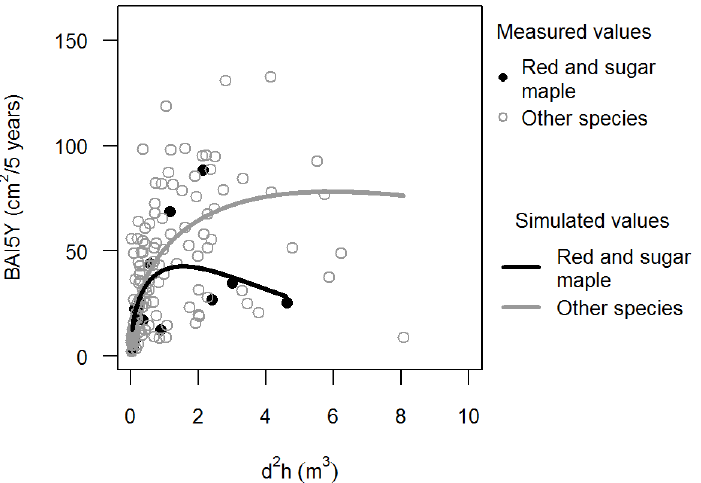
Figure 4. Effect of the main competitor species (MCS) of the subject tree on its basal area increment over a 5 years period ( BAI 5 Y ). Values for BAI 5 Y were simulated across the range of d 2 h represented in the dataset for each class of MCS in order to remain within the domain of validity of the model. Altitude was fixed to its mean value within the dataset (397